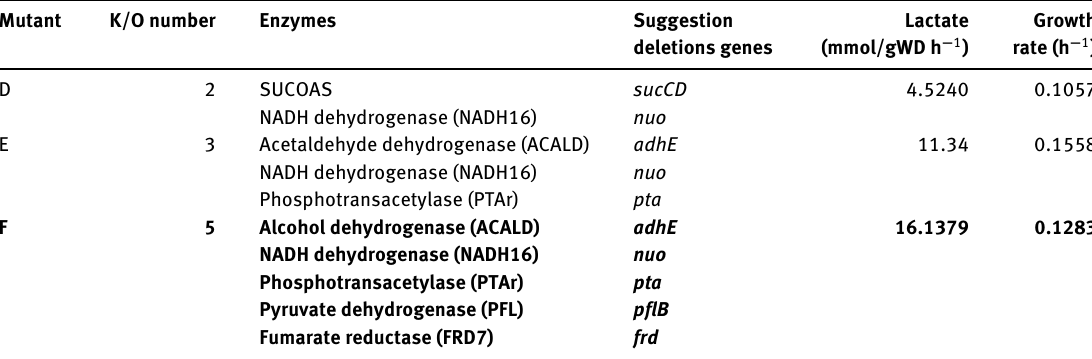
Table 3: Knockout lists for lactate in E.